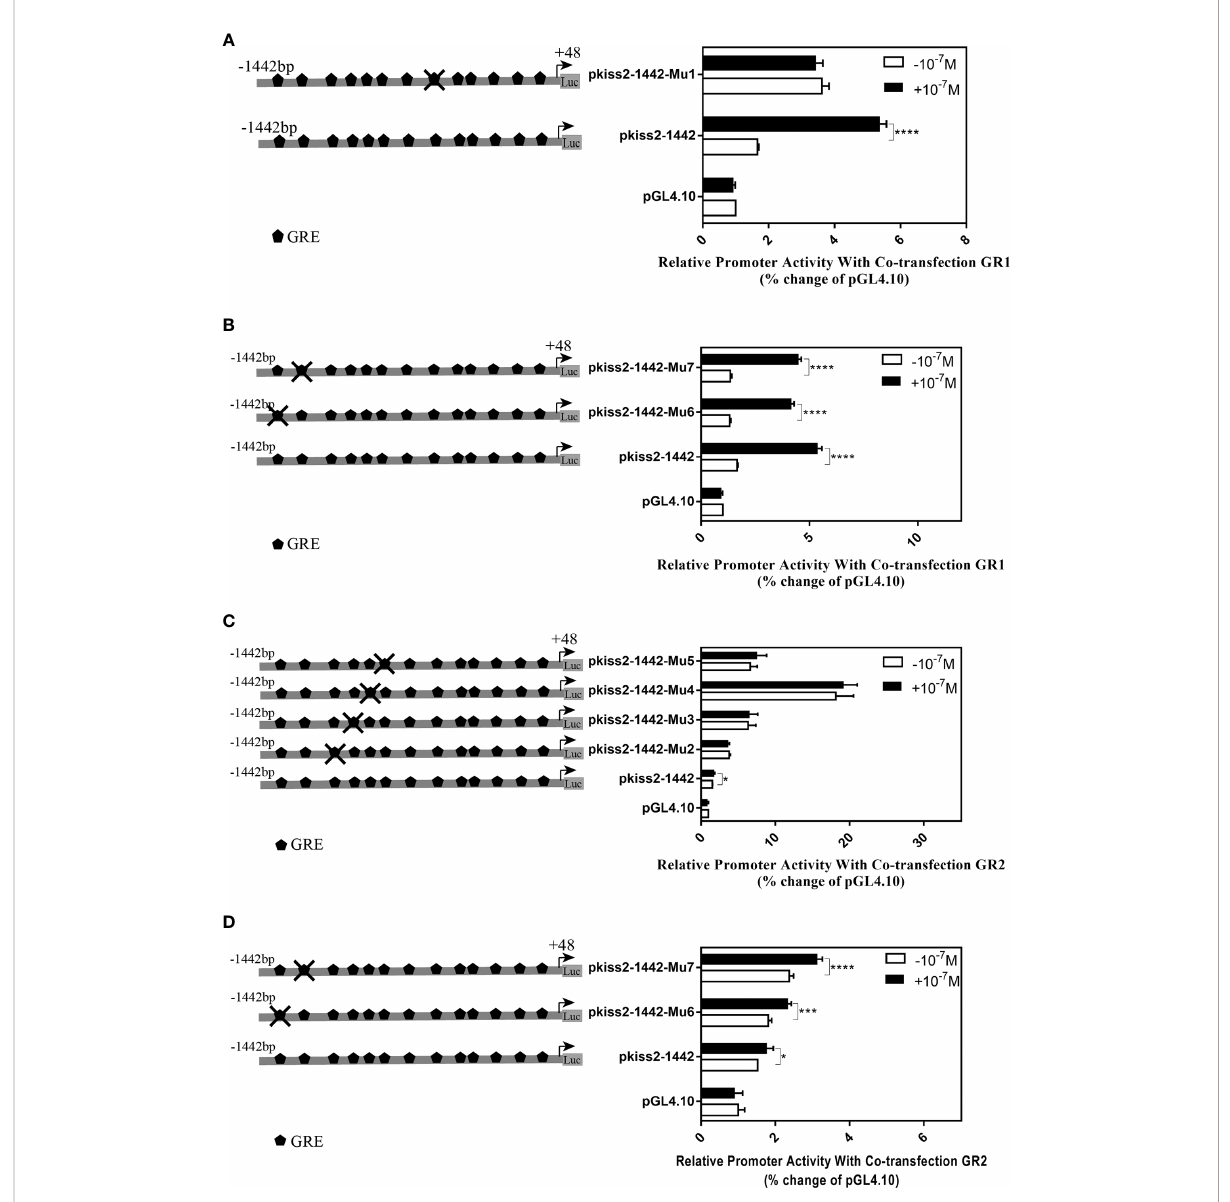
FIGURE 8 Mutations of the putative glucocorticoid receptor binding sites in kiss2 promoter. Schematic of mutated GRE sites is shown on the left. HEK- 293T cells were transfected with GRE-mutated promoter constructs and pRL-CMV with GR1 (A, B) or GR2 (C, D) expression plasmid. Cells were incubated with or without 10 − 7 M cortisol treatment. Relative promoter activities are expressed as percentage of pGL4.10 in the absence of cortisol. Data are represented as mean ± SEM (n = 4). * (p < 0.05), *** (p < 0.001), and **** (p < 0.0001) indicate signi fi cant differences compared with the corresponding